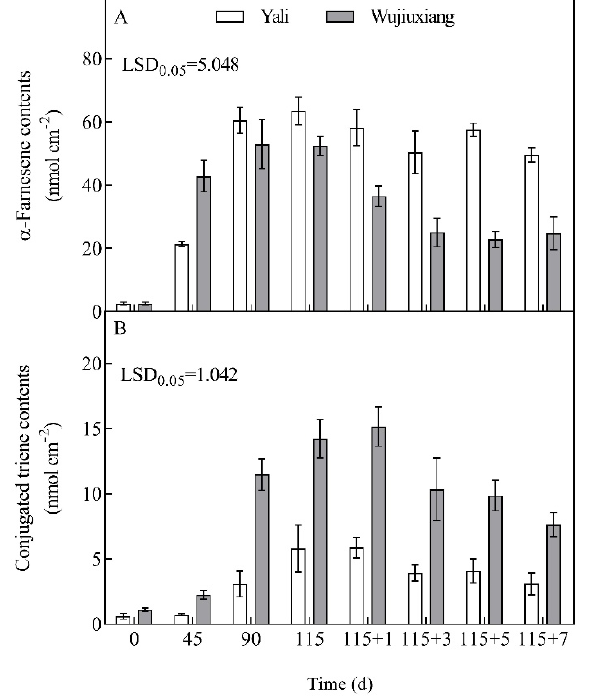
Figure 2. Contents of α -farnesene ( A ) and CTols ( B ) in the peels of ‘Yali’ and ‘Wujiuxiang’ pear during cold storage and the shelf life period. Vertical bars represent standard errors and LSD values represent significant differences at the level of 0.05. Note: 115 + 1, 115 + 3, 115 + 5, and 115 + 7 indicate 1, 3, 5 and 7 days of shelf life at room temperature (20 °C) after cold storage at 0 °C for 115 days.